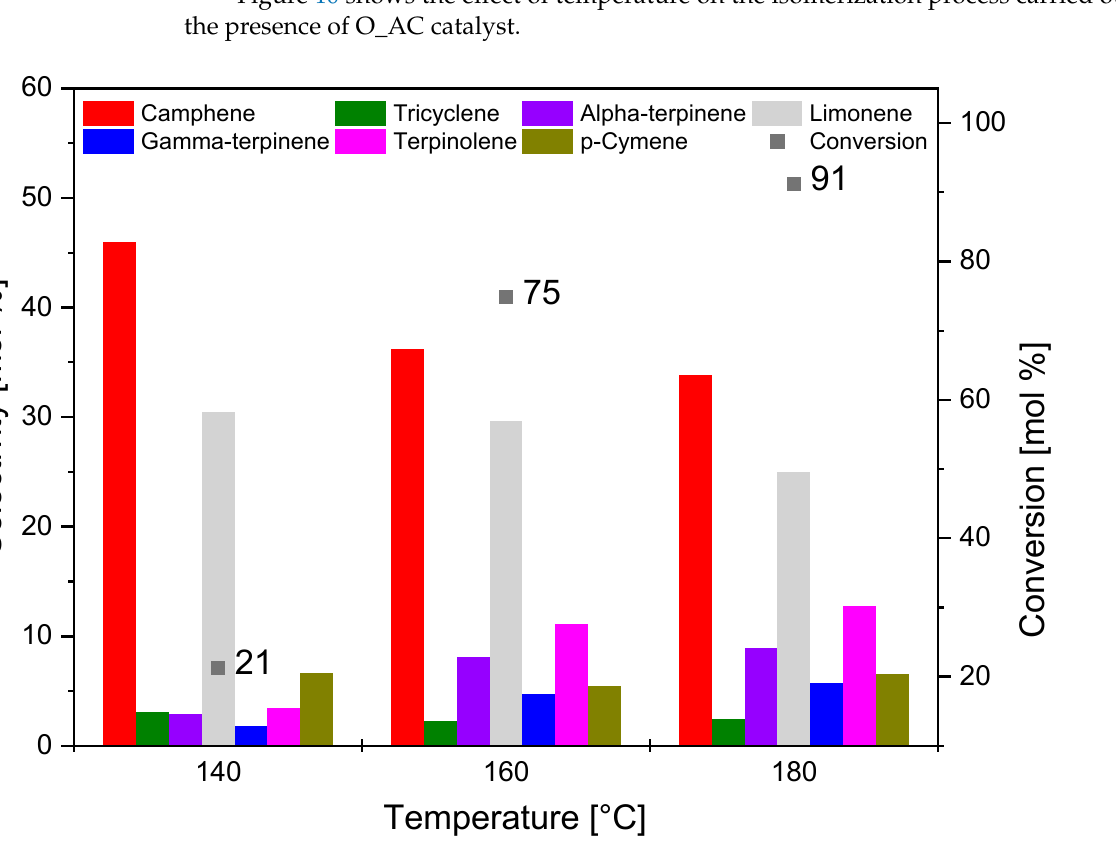
Figure 10. Comparison of the selectivity of the main products and the conversion of organic raw material (alpha-pinene) at different temperatures after 3 h for the O_AC sample.